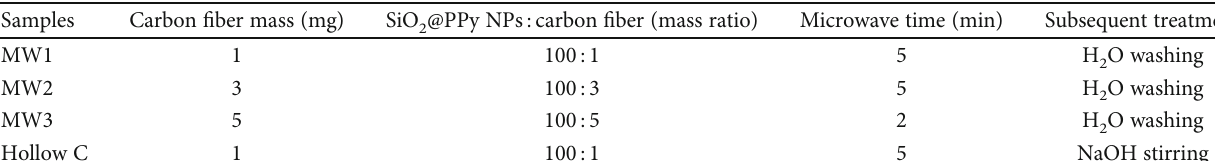
Table 1: Microwave parameters of each group.